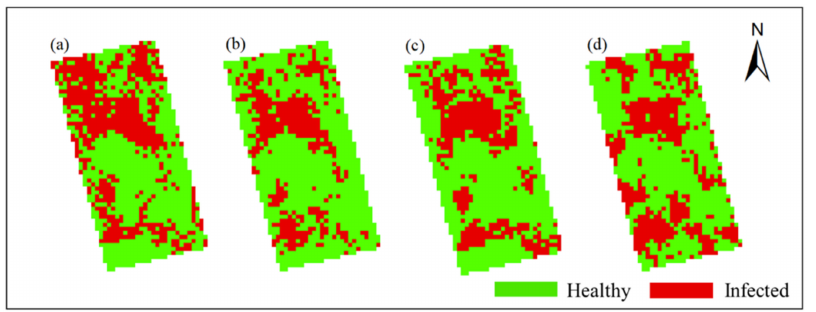
Figure 13. Spatiotemporal distribution of occurrence information of rice false smut in Plot 2: ( a ) 14 August 2020; ( b ) 20 August 2020; ( c ) 25 August 2020; ( d ) 6 September 2020.